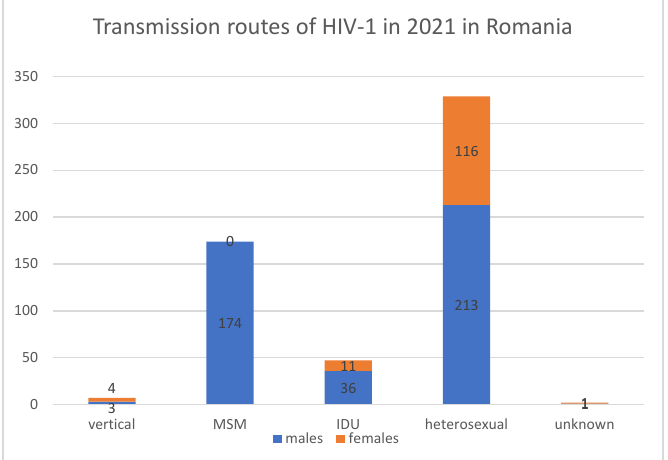
Figure 1. Transmission routes of HIV-1, in 2021, in Romania.